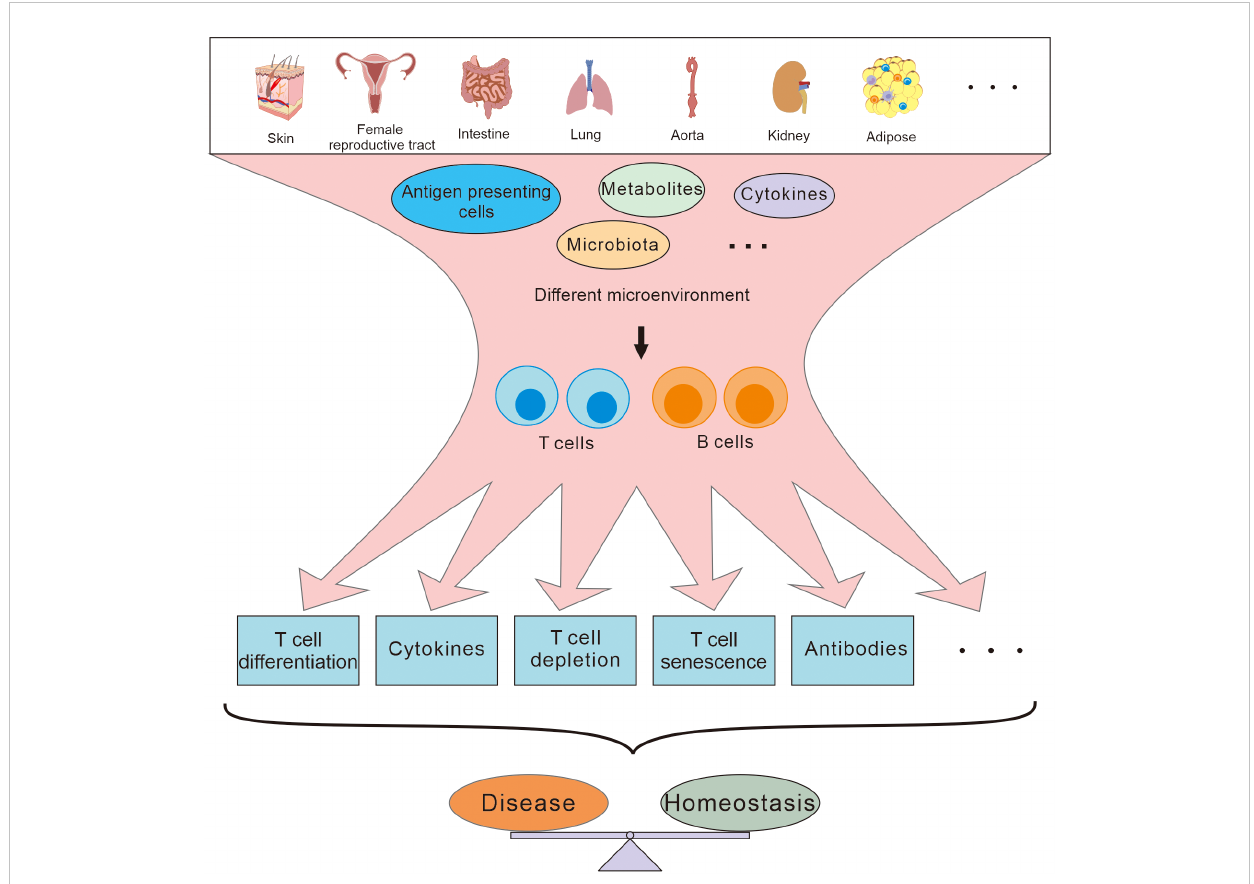
FIGURE 1 T and B cells residing in different peripheral tissues are involved in maintaining the homeostasis and disease development in different ways depending on the different